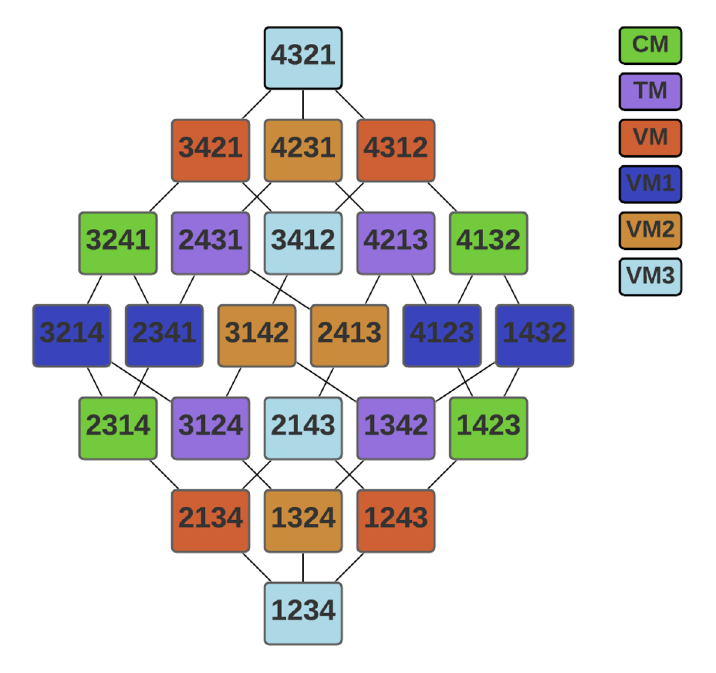
Figure 6 . Weak ordering in BC 4